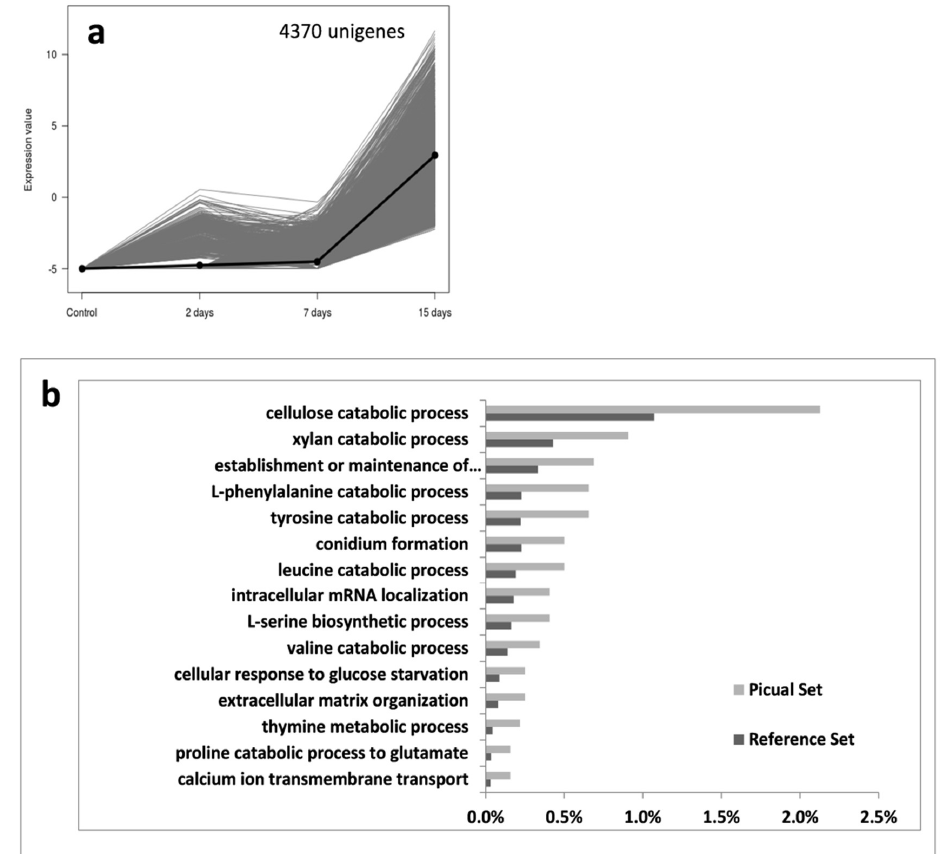
Figure 4. Group 6 unigenes that present a high mRNA level at 15 days but low at 2- and 7-days post-inoculation. Unigenes were selected using an eightfold change and a 95% of False Discovery Rate; mRNA level in ‘Picual’ roots ( a ) and most specific enriched GO terms of over-expressed genes in Verticillium dahliae infecting ‘Picual’ roots ( b ).